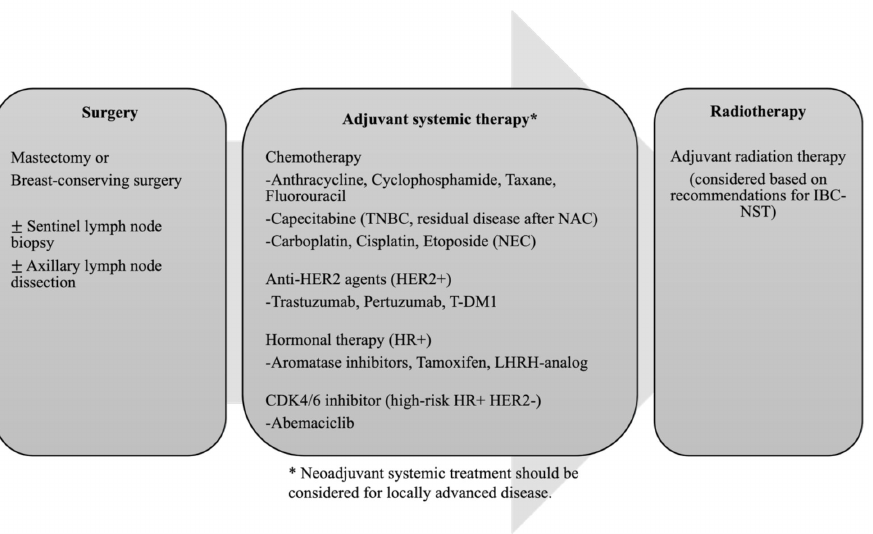
Figure 5. Overview of treatment strategy for resectable Br-NEN. Treatment strategy including surgery, adjuvant systemic therapy, and radiotherapy should be considered based on recommendations for IBC-NST. Neoadjuvant systemic therapy should be considered for locally advanced